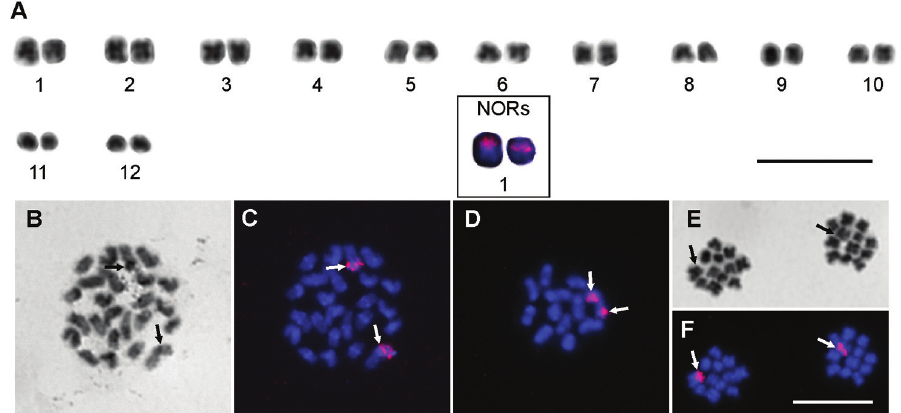
Figure 4. Chromosomes of Rhampsinitus qachasneki (2n=24) males after Giemsa staining ( A, B, E ) and after FISH with 18S rDNA ( A partly, C, D, F ). A male karyotype based on two sister cells of metaphase II B, C mitotic metaphase D diakinesis E, F two sister cells of metaphase II. White arrows indicate the position of 18S rDNA and black arrows indicate the same position after Giemsa staining. Bar = 10